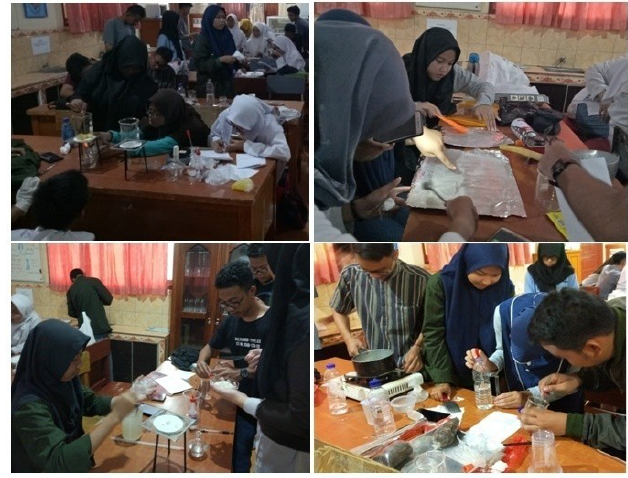
Figure 6. Students working on a biodegradable plastic making